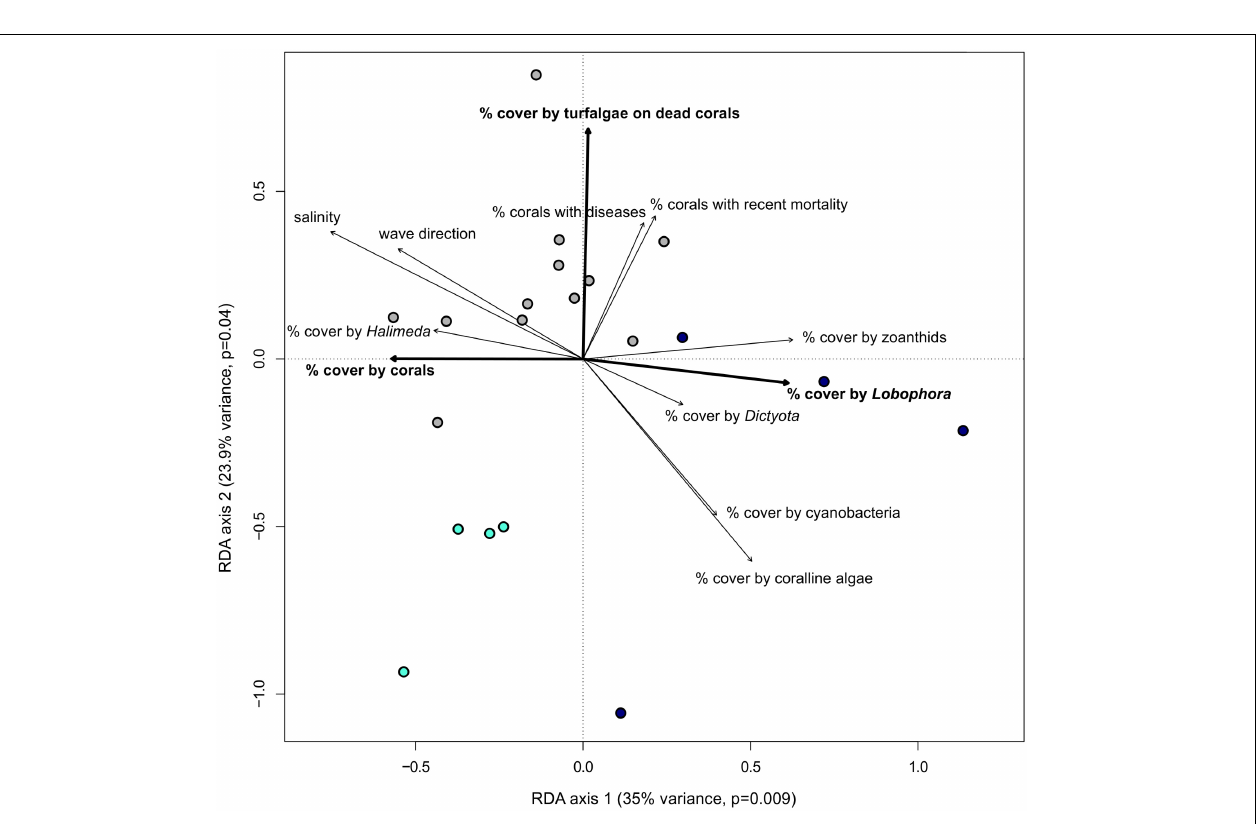
Frontiers in Marine Science |